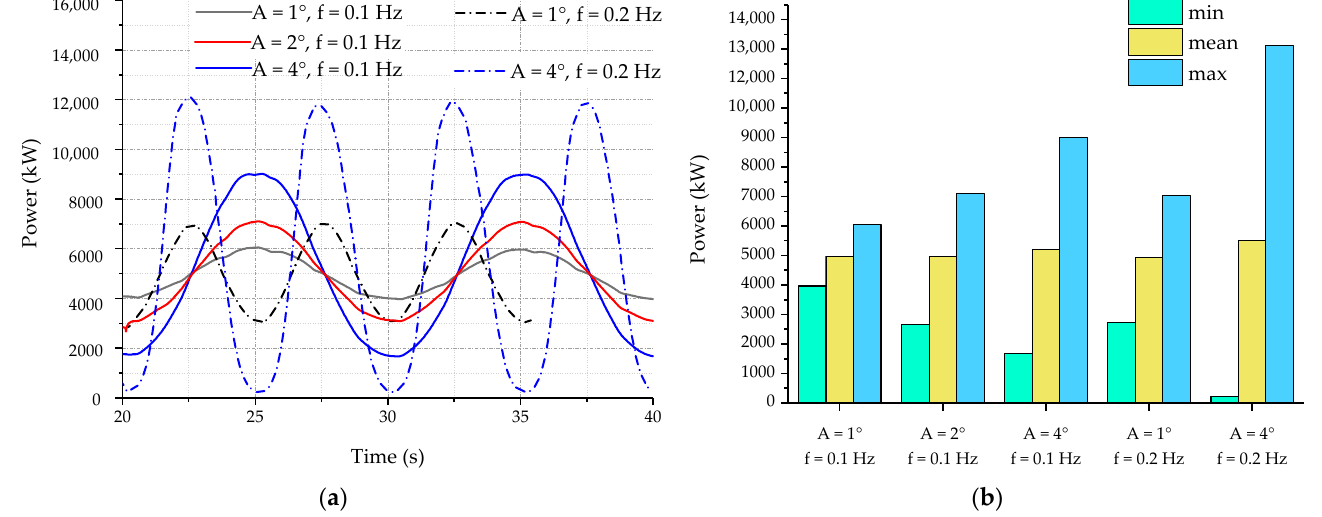
Figure 5. Power performance under pitch motion. ( a ) Power variation versus time; ( b ) the average and extreme power.